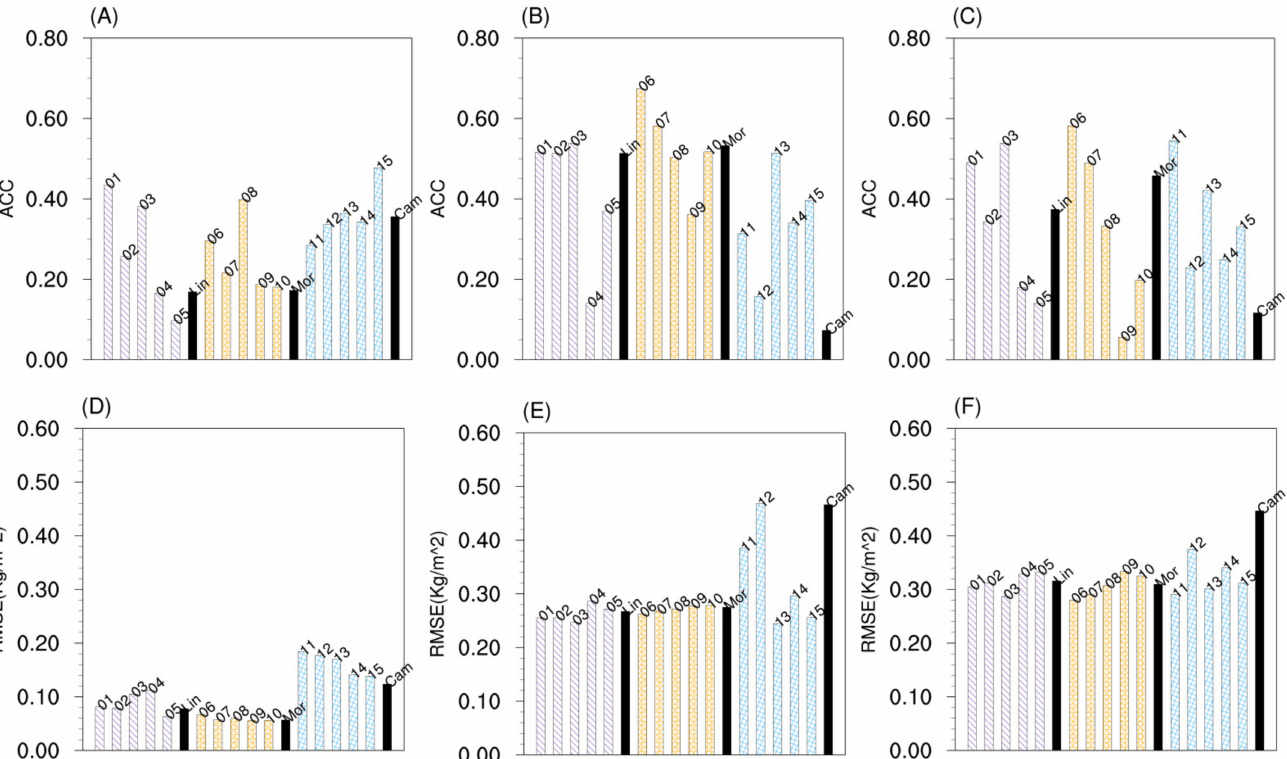
Figure 4. The ACC and RMSE (kg · m − 2 ) of the ( A , D ) cloud water path, ( B , E ) rainwater path, and ( C , F ) ice water path simulated by the 3 schemes (black filled bars) and the 15 perturbed members of the multi-physical ETKF with Lin, Morrison 2-mom, CAM5.1 microphysical parameterization schemes on 12 August 2014. The purple-filled bars (01–05) denote the results of the 5 perturbed members adopting the Lin scheme, the yellow-filled bars (06–10) indicate the results of the Morrison 2-mom scheme, the blue-filled bars (11–15) represent the results of the CAM5.1